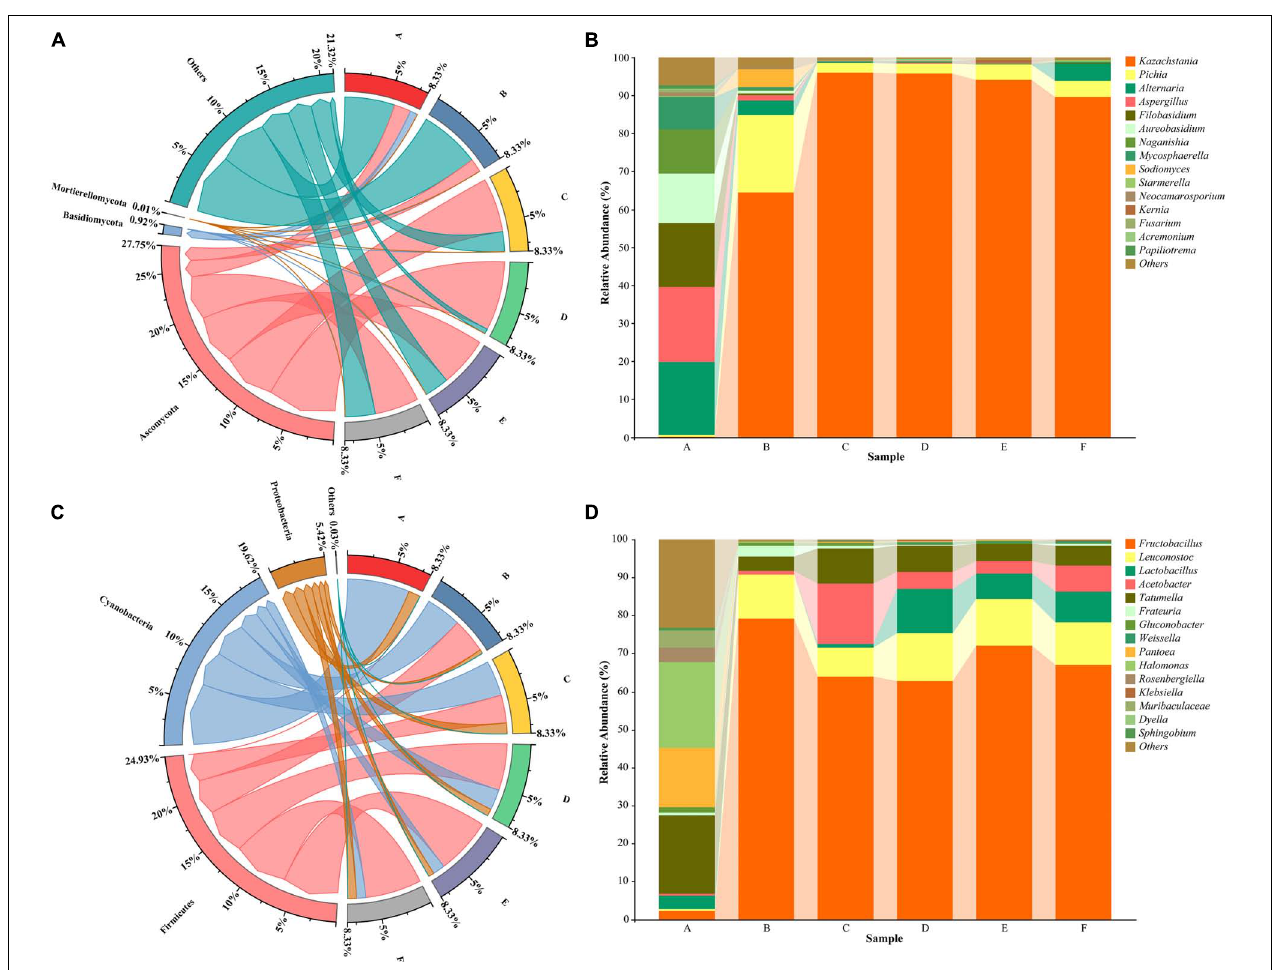
FIGURE 3 | Differences in fungal (A) and bacterial (C) communities after different fermentation periods at the phylum level. The relative abundance of the top 15 fungi (B) and bacteria (D) at the genus level. A, B, C, D, E, and F Represent samples collected on fermentation days 0, 3, 6, 9, 12, and 16,